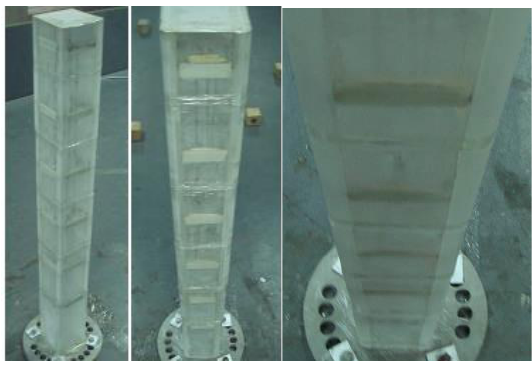
Figure 11. Some photos of the MDOF model with rounded corners. Table 2. The structural parameter of rounded-corner models .